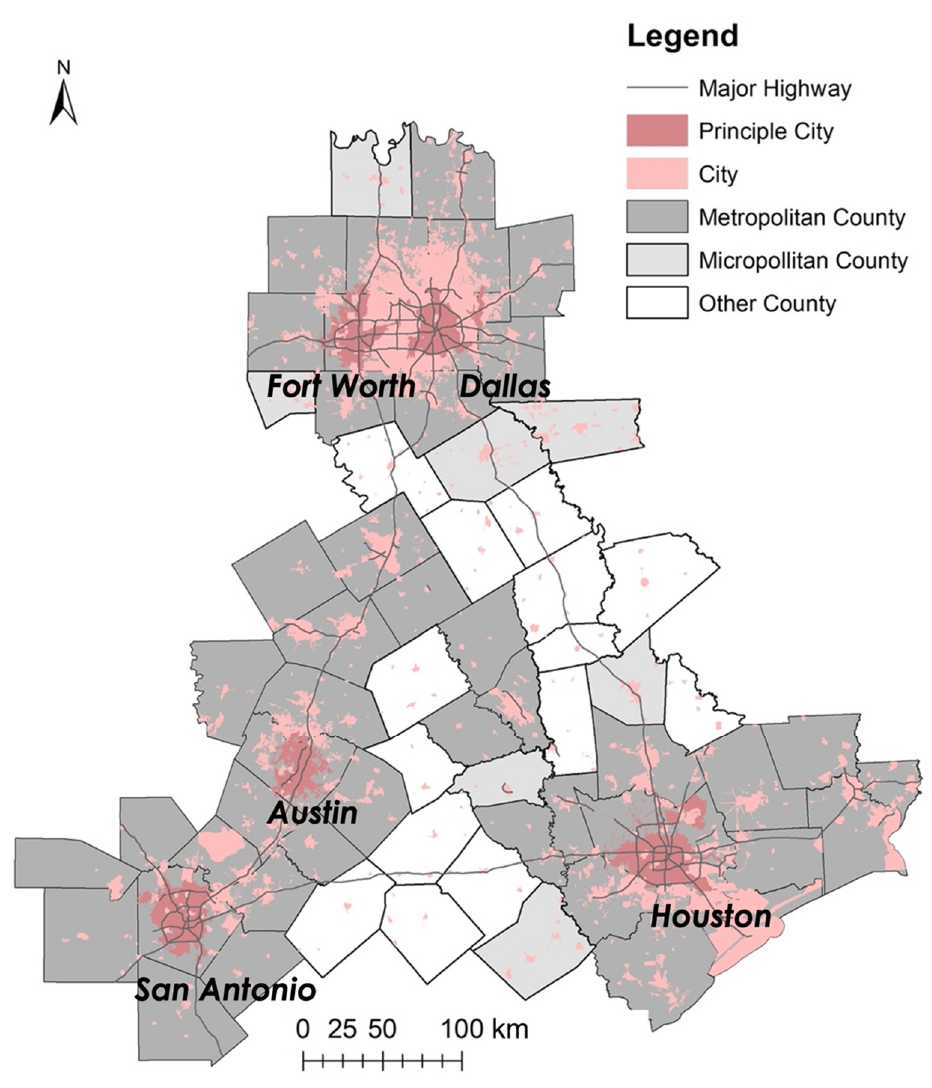
Figure 2. The Texas Triangle.